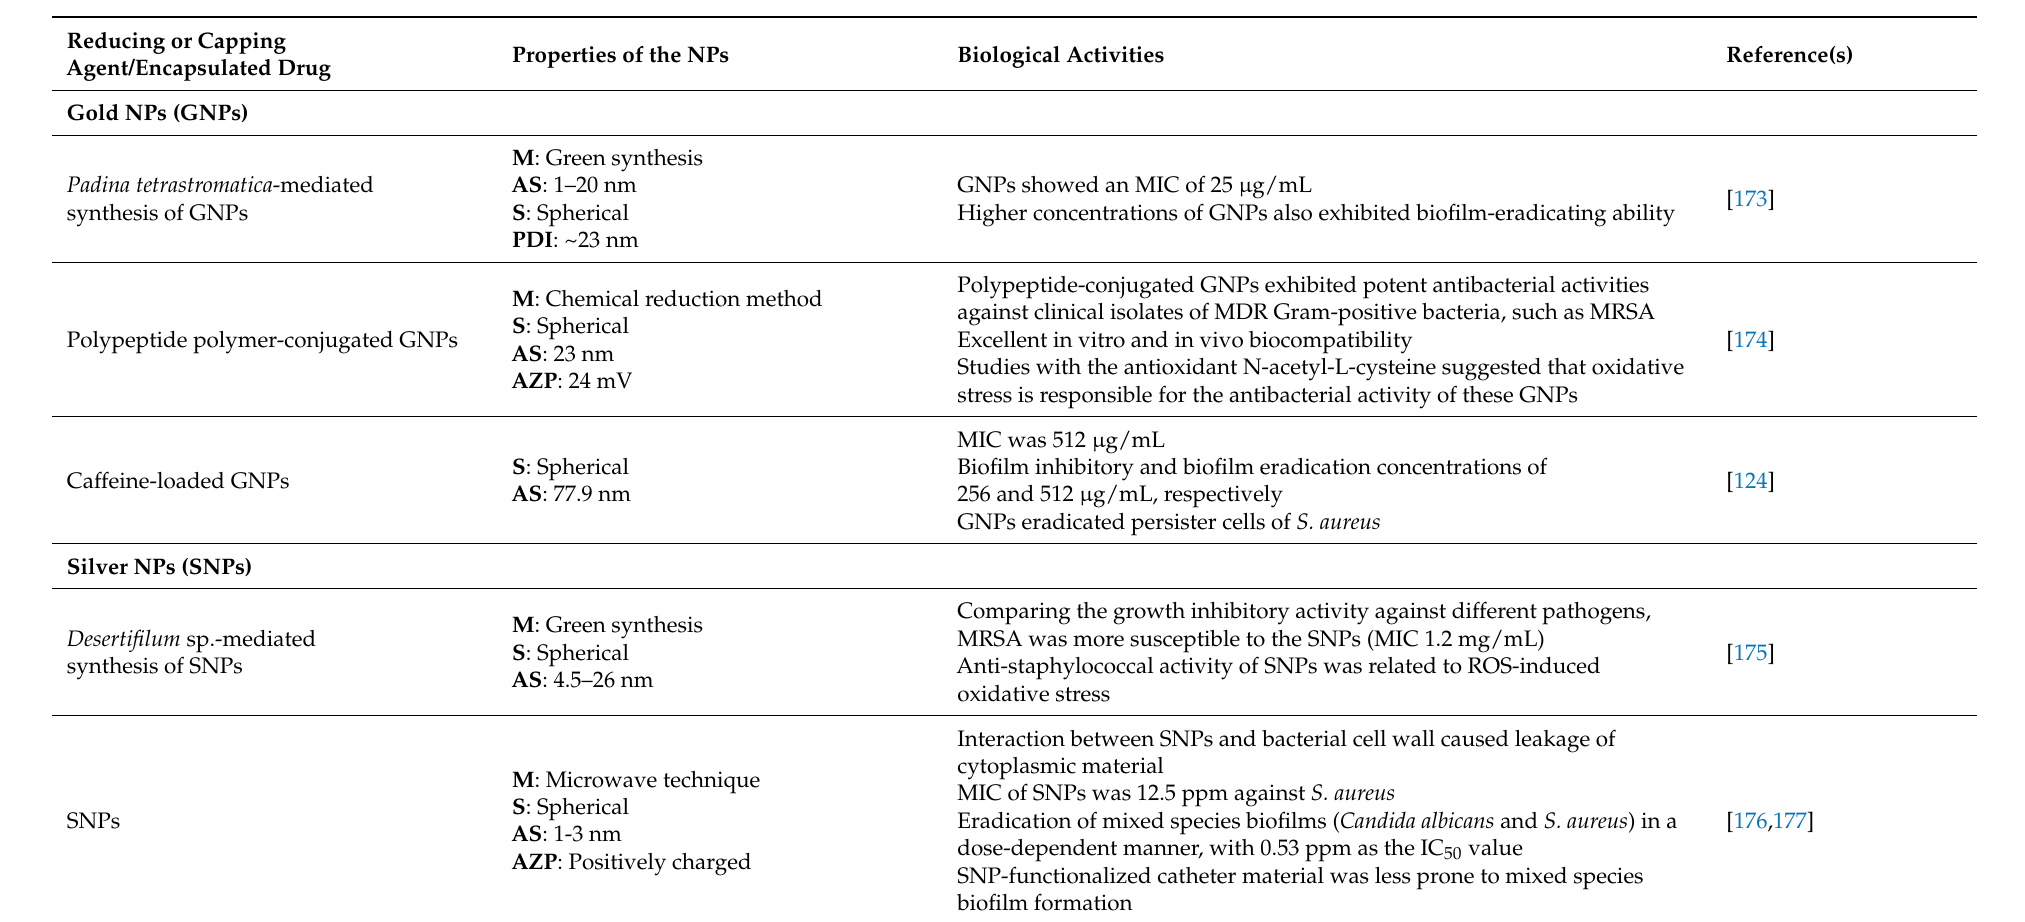
Table 3. Recent studies on the control of Staphylococcus aureus growth and biofilm formation using different types of inorganic nanoparticles (NPs). The method of preparation (M), shape (S), average/particular size (AS), zeta potential (AZP), polydispersity index (PDI), encapsulation efficiency (EE), and drug loading capacity (DL) are indicated based on the original